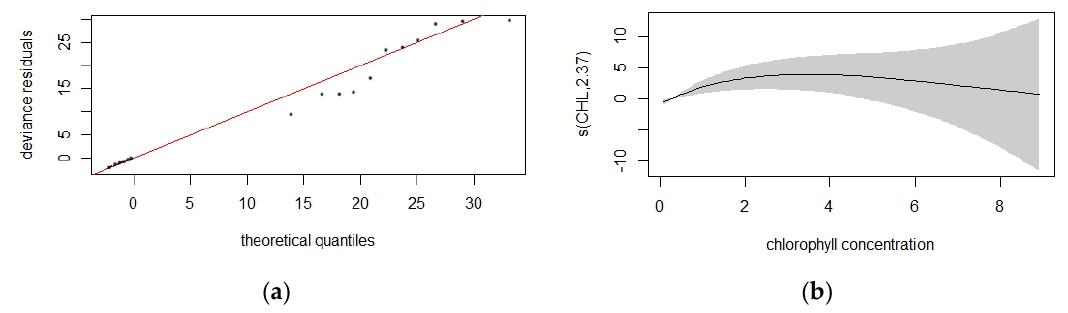
Figure 9. Quantile–quantile plot with Tweedie response distribution and the variables latitude, longitude, and chlorophyll ( a ). Smooth function for chlorophyll concentration ( b ). Grey shading corresponds to 95% confidence levels, and the numbers in brackets on the vertical axis labels give the effective degrees of freedom of the term.